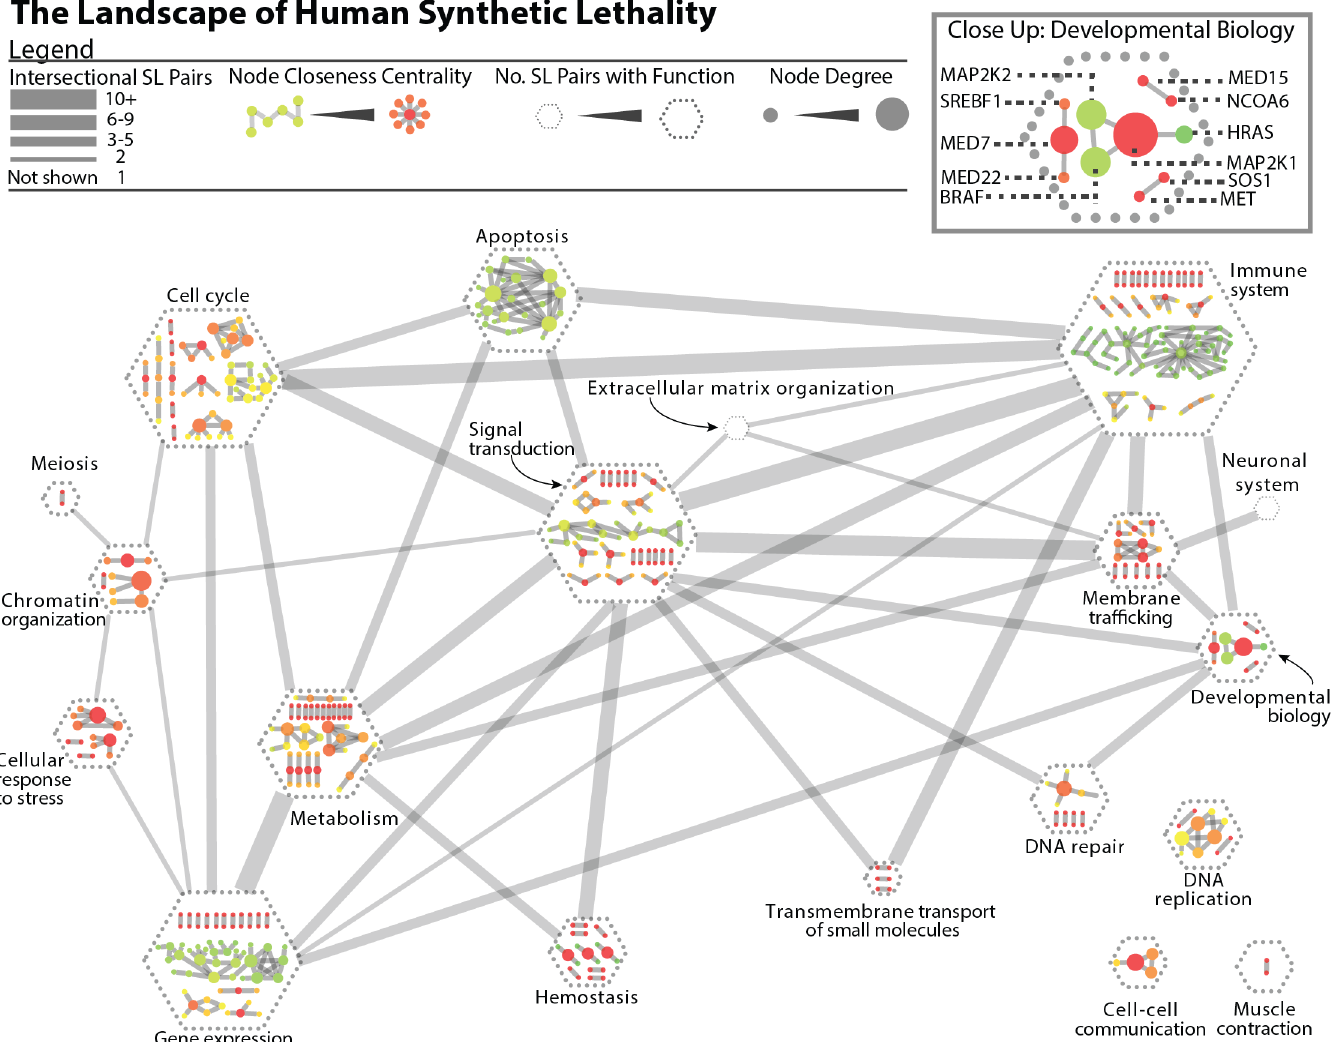
Fig 4. The landscape of human synthetic lethality. This network depicts all gene pairs with SINaTRA score (cid:1) 0.95 (1,229 SL pairs) that map to Reactome pathways (458 pairs). Here, each hexagon represents one high-level pathway designation in Reactome. Larger nodes indicate more SL pairs with that designation. Within the hexagonal nodes, we show the networks of synthetic lethality where both members have the same function in Reactome. Each node is a gene and an edge represents a predicted SL interaction. Gene nodes are weighted by degree and colored by closeness centrality. In turn, weighted edges join hexagonal nodes if pathway-divergent pairs exist; that is, one member of the pair is of one pathway while the second member is of the other. Edges are weighted by the number of pathway-divergent gene pairs associated with both